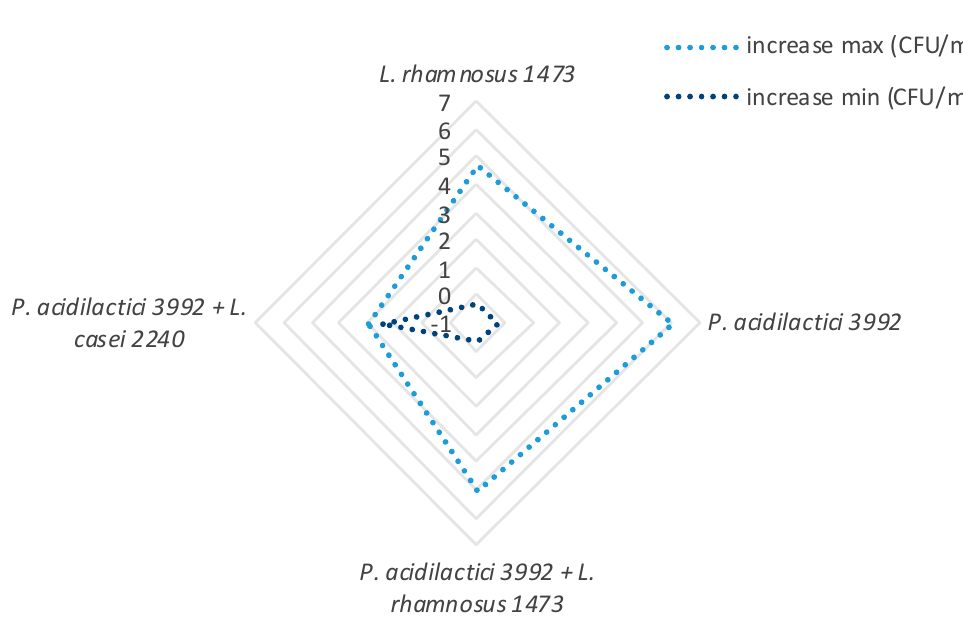
Figure 4. Combinations marked in the boxes showing the highest (light blue) and lowest (dark blue) microbial increase ( Δ Log CFU/mL), for each substrates. X axis reports the products and y axis reports the microbial count expressed as Log CFU / mL.